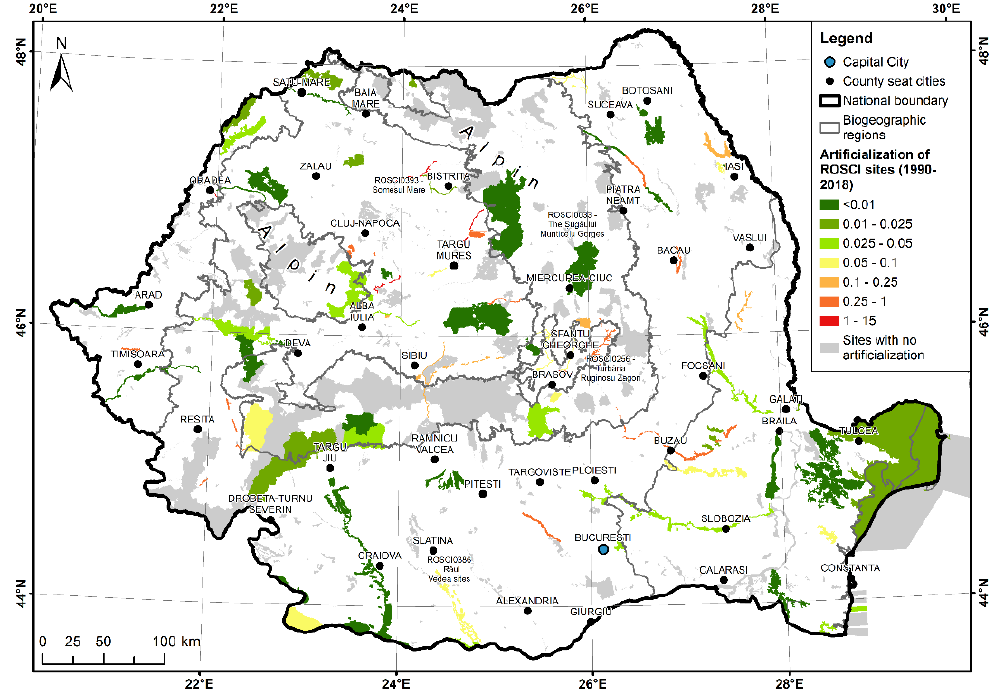
Figure 22. Percentage of artificialization in ROSCI sites.